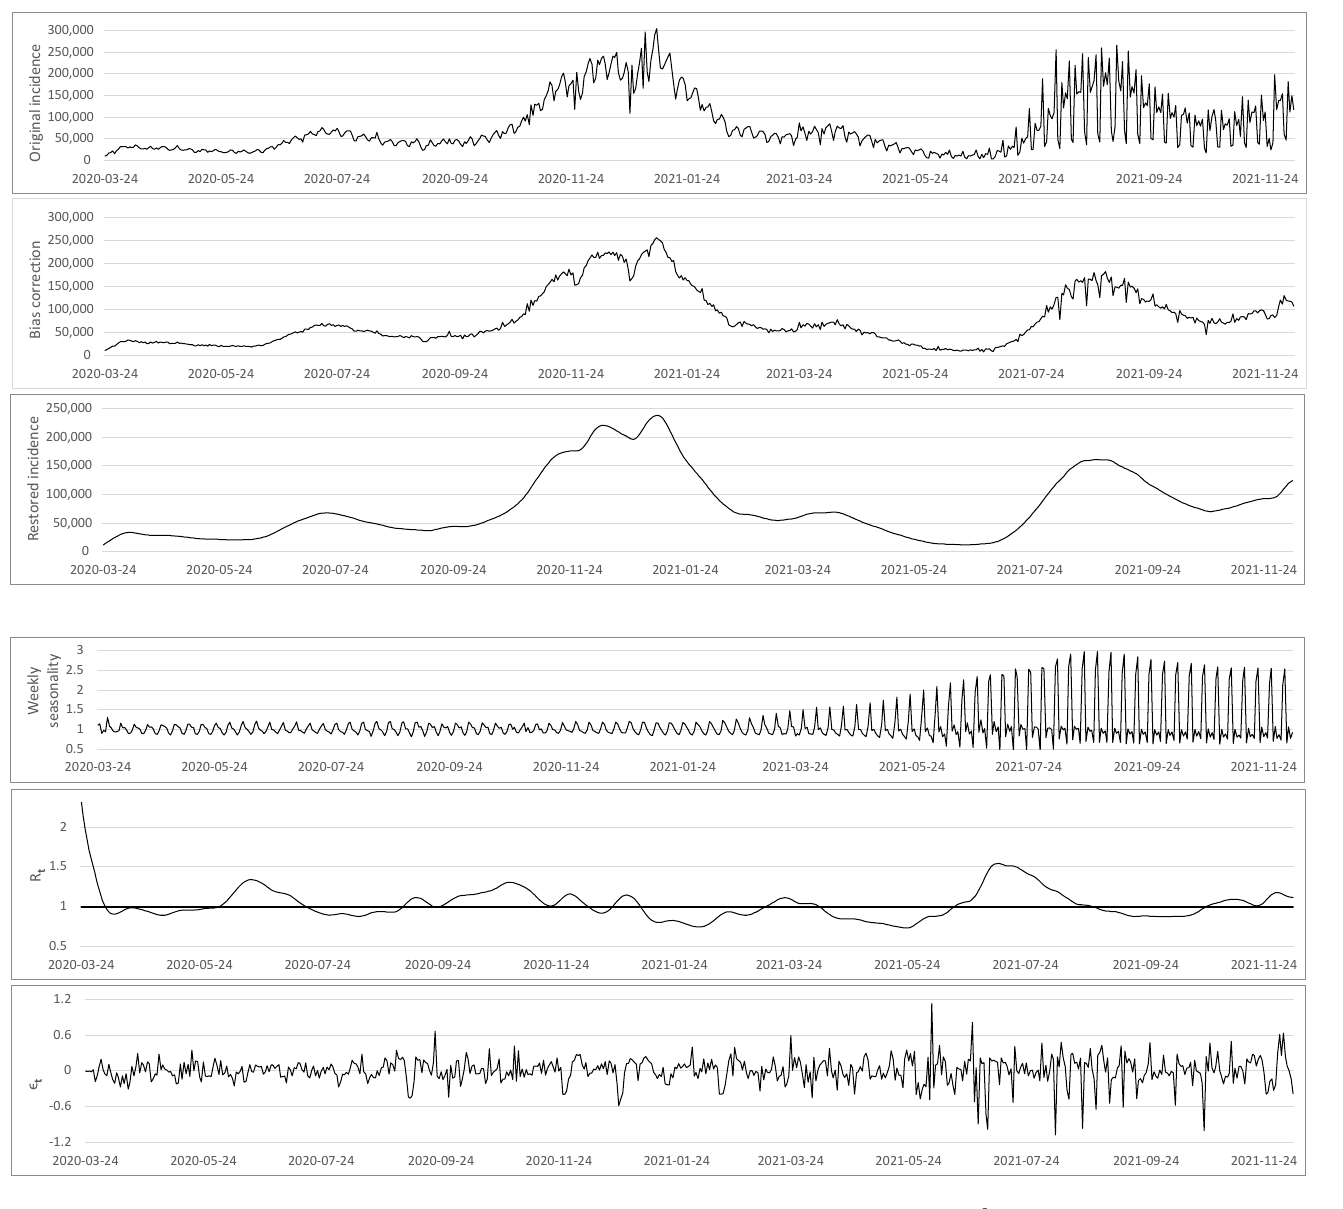
of USA, (ii) the incidence curve t , (iv) the weekly t